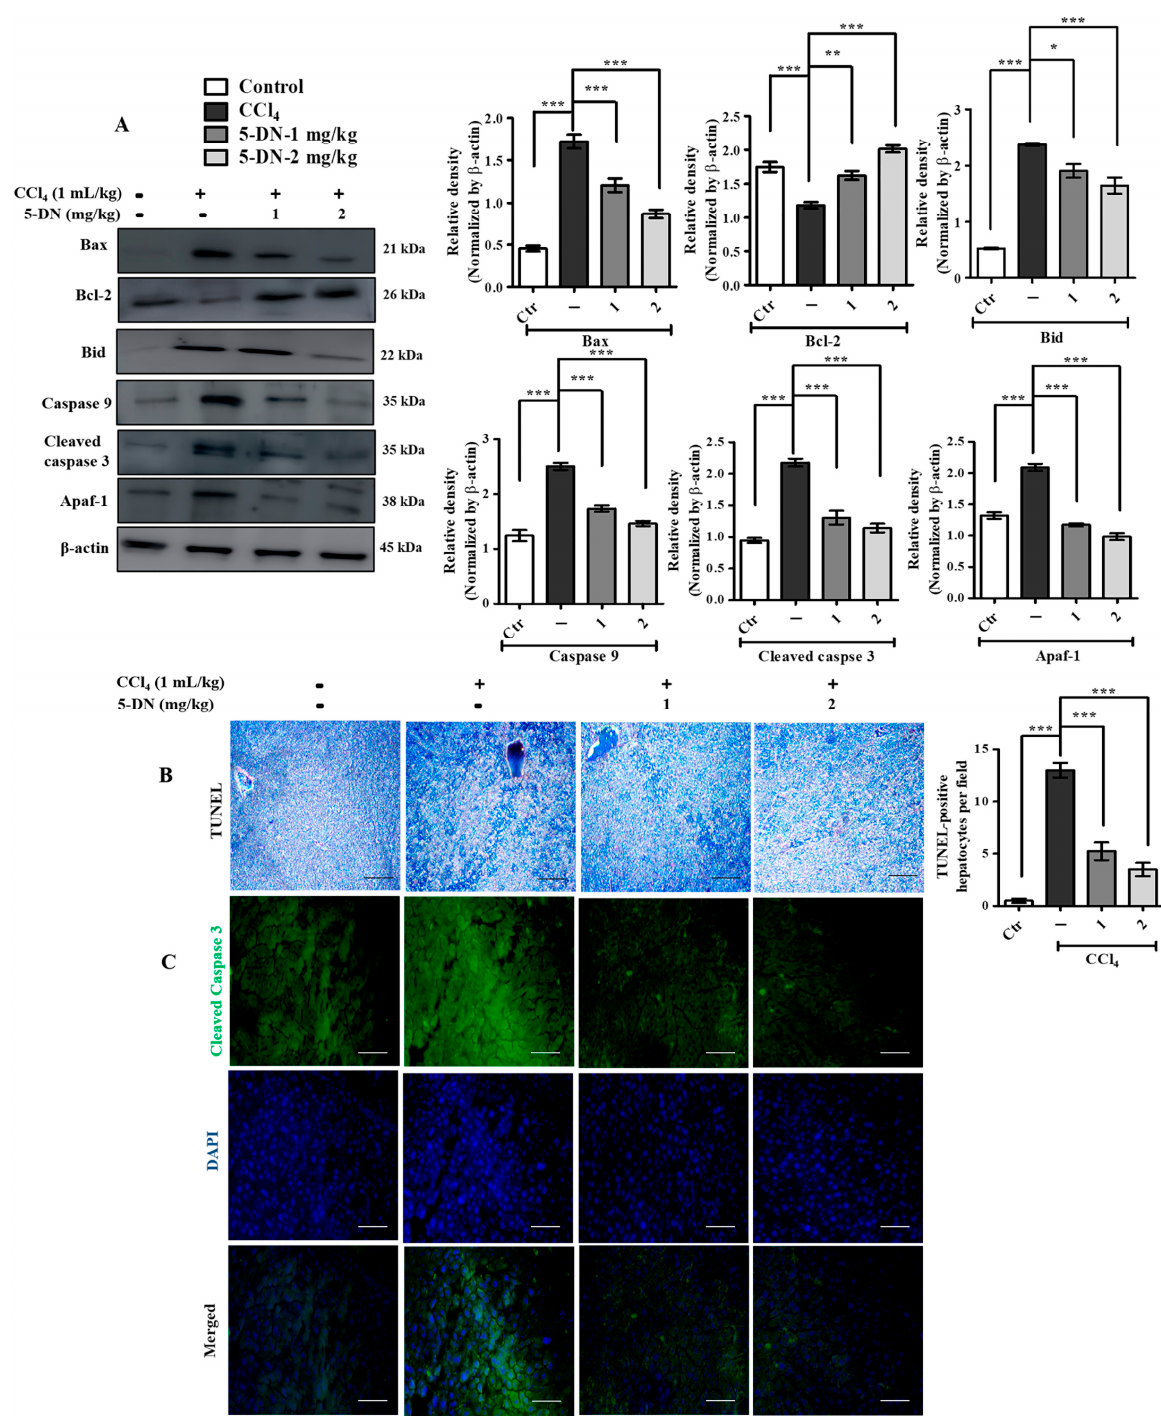
Figure 6. 5-DN blockaded CCl 4 -induced apoptosis. (mice, n = 6/group). ( A ) Western blotting analysis of apoptosis markers and their quantification. ( B ) TUNEL assay to determine the occurrence of apoptosis. TUNEL-positive hepatocytes were counted from five different representative fields for all the groups and were evaluated and averaged for making the graph (Magnification: 200 × ). ( C ) Immunofluorescence staining of cleaved caspase 3 from BALB/c liver tissue (Magnification: 400 × , Scheme 100 µ M). Images were captured using Olympus BX51 fluorescence microscope. Densitometry analysis of these respective proteins were normalized by β -actin and evaluated through Image J software. The data are represented as mean ± S.D. of three independent experiments * p < 0.05, ** p < 0.01, *** p < 0.001 and ns (non-significant). Control vs. CCl 4 , CCl 4 vs. 5-DN (1–2 mg/kg). Statistical significance analysis was carried out through one-way analysis of variance (ANOVA)